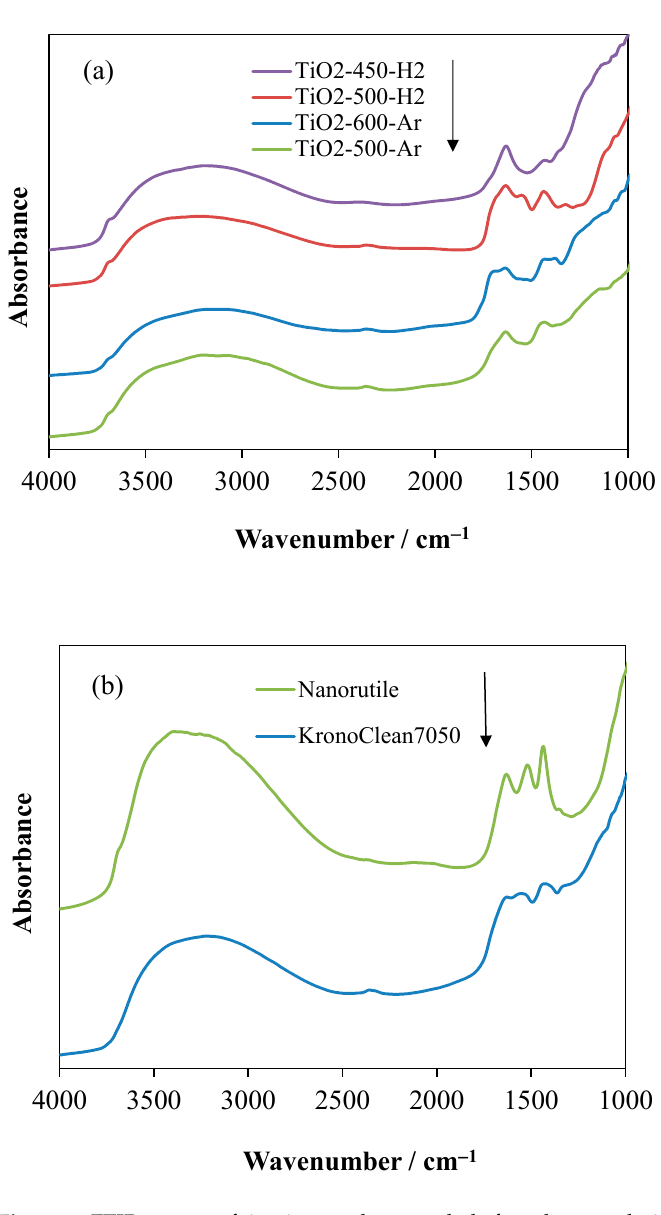
Figure 9. FTIR spectra of titania samples recorded after photocatalytic decomposition of